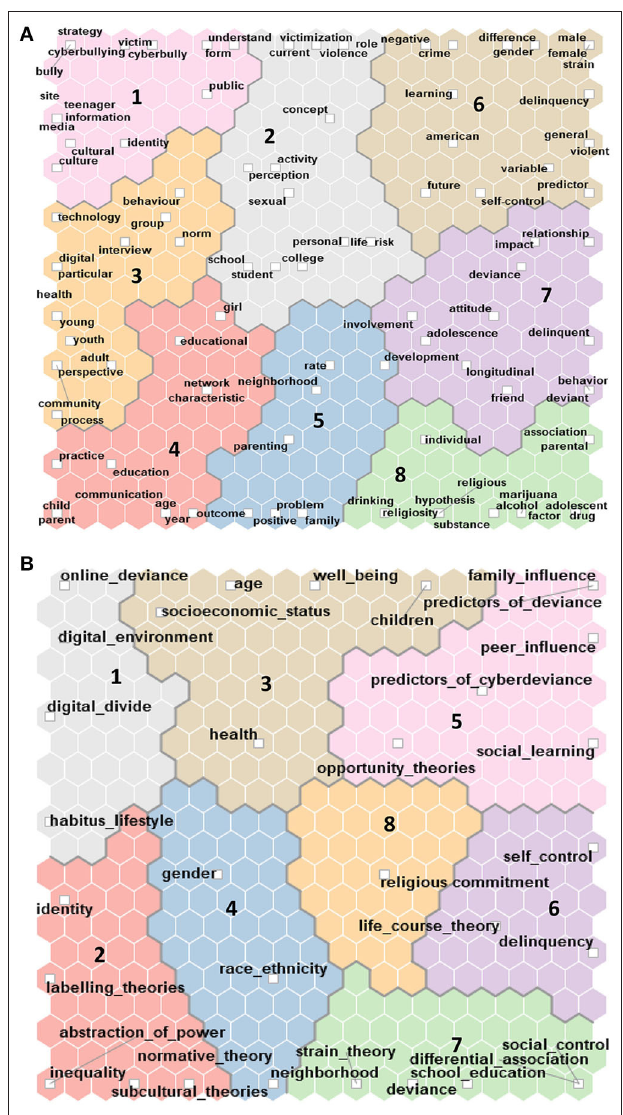
FIGURE 10 | (A) Self-organizing map Data set 2. (B) Self-organizing map Data set